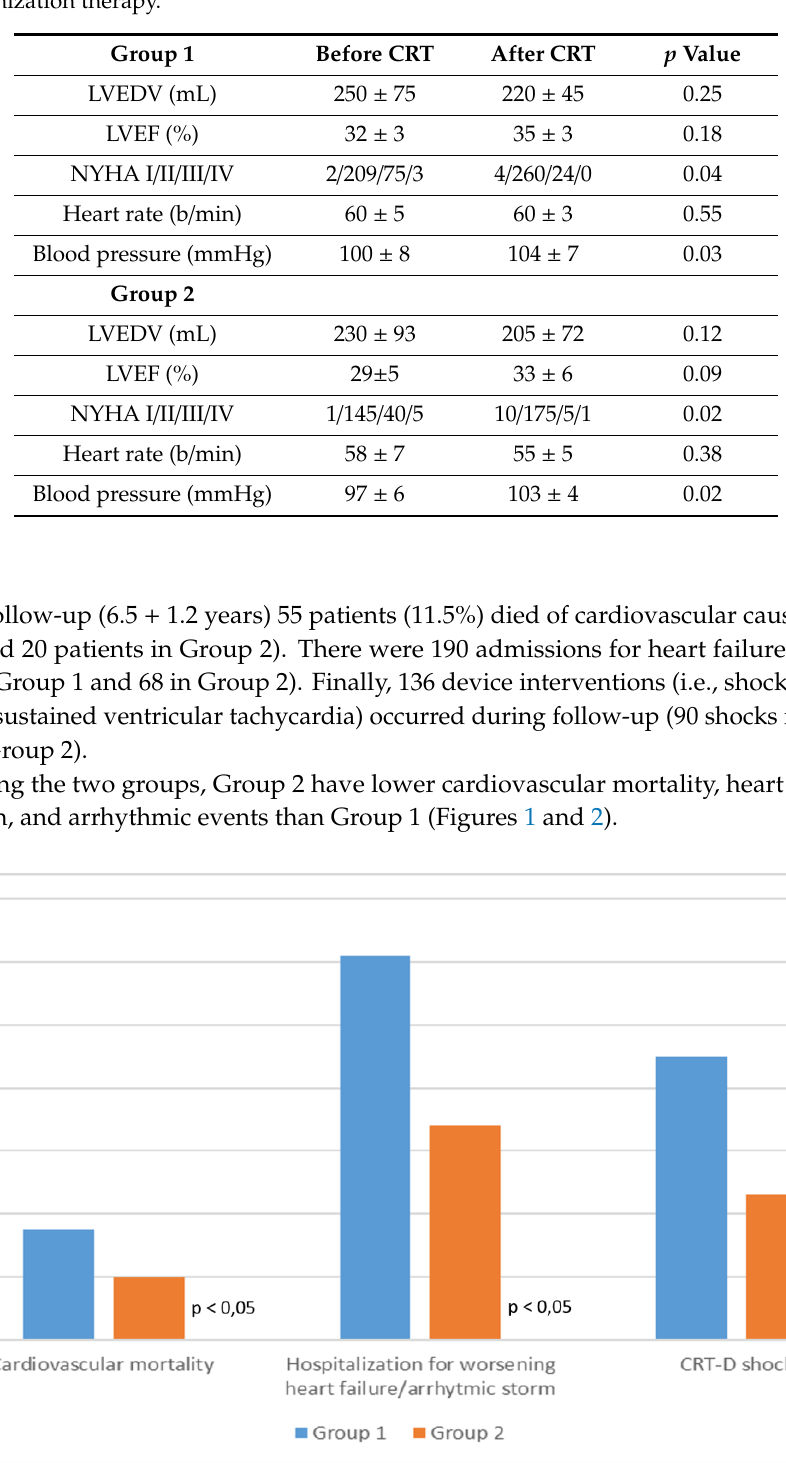
Figure 2. Kaplan-Meier curves of the two study groups. 5. Discussion The main results of this study are that, with patients with HFrEF undergoing CRT implantation, it is possible to increase the doses of BBs and that the use of high doses allows better clinical results to be obtained. Initial experience with BBs in HFrEF was reported in 1979 [17]. However, the first randomized multicenter study was published in 1993 [18], while only in 1997 carvedilol was approved for the treatment of HFrEF. The rationale for the slow acceptance of β -blocker therapy in HFrEF is related to the risk of worsening of HF [19]. Nowadays the available data show that carvedilol, bisoprolol, and metoprolol reduce morbidity and mortality in patients with symptomatic HFrEF [20]. However, clinical studies that have demonstrated the e fficacy of β -blockers in HFrEF have been conducted before the spread of CRT, and such therapy may attenuate hypotension and symptomatic bradycardia which are significant factors limiting the use of high-dose BBs. 1 2